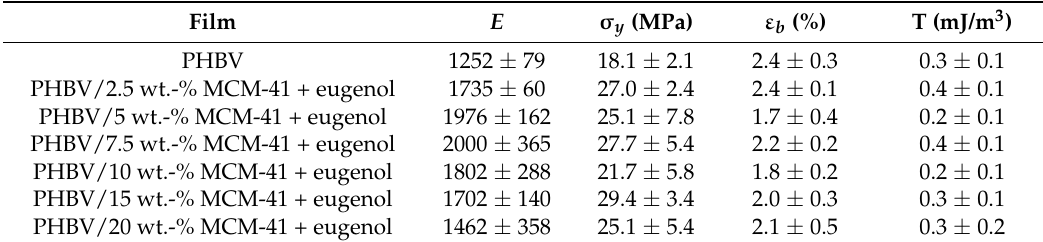
Table 4. Mechanical properties in terms of elastic modulus (E), tensile strength at yield ( σ y ), elongation at break ( ε b ), and toughness (T) for the electrospun films of poly(3-hydroxybutyrate- co -3-hydroxyvalerate) (PHBV) and PHBV/Mobil Composition of Matter (MCM)-41 with